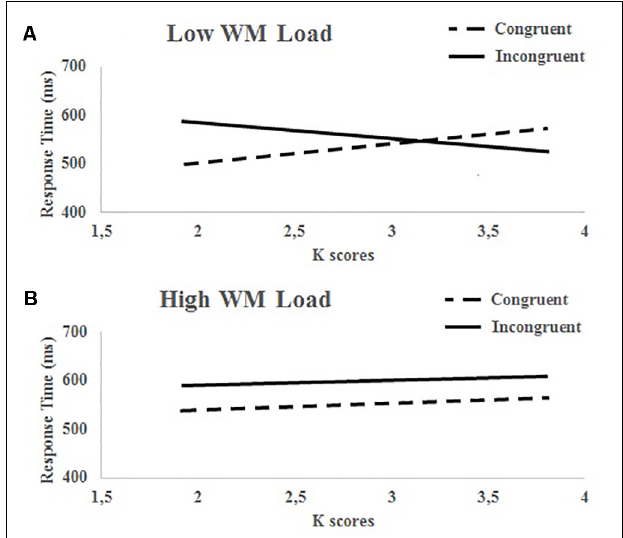
FIGURE 3 | Participants’ response times (ms) for congruent and incongruent conditions in the Stroop task as a function of WMC ( k ) scores under low (A) and high (B) WM load in Experiment